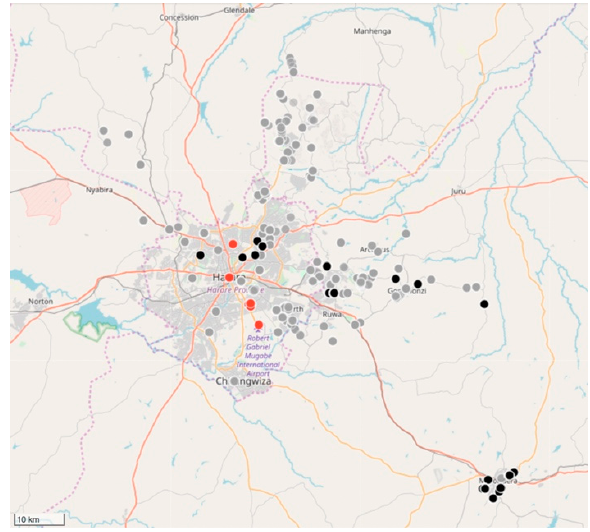
Figure 6. Map of Harare showing the location of laboratory-confirmed rabies cases (red dots), location of vaccinated animals in 2018 (grey dots) and the locations of vaccinated animals in 2019 (black dots). The number of rabies cases per location is displayed in terms of the size and the number within each red dot. Only the location of the vaccinated animals is displayed on the map (grey and black dots) for ease of interpretation. On this specific map, the total number of grey and black dots represent the 11,784 animals vaccinated between February 2018 and March 2019.